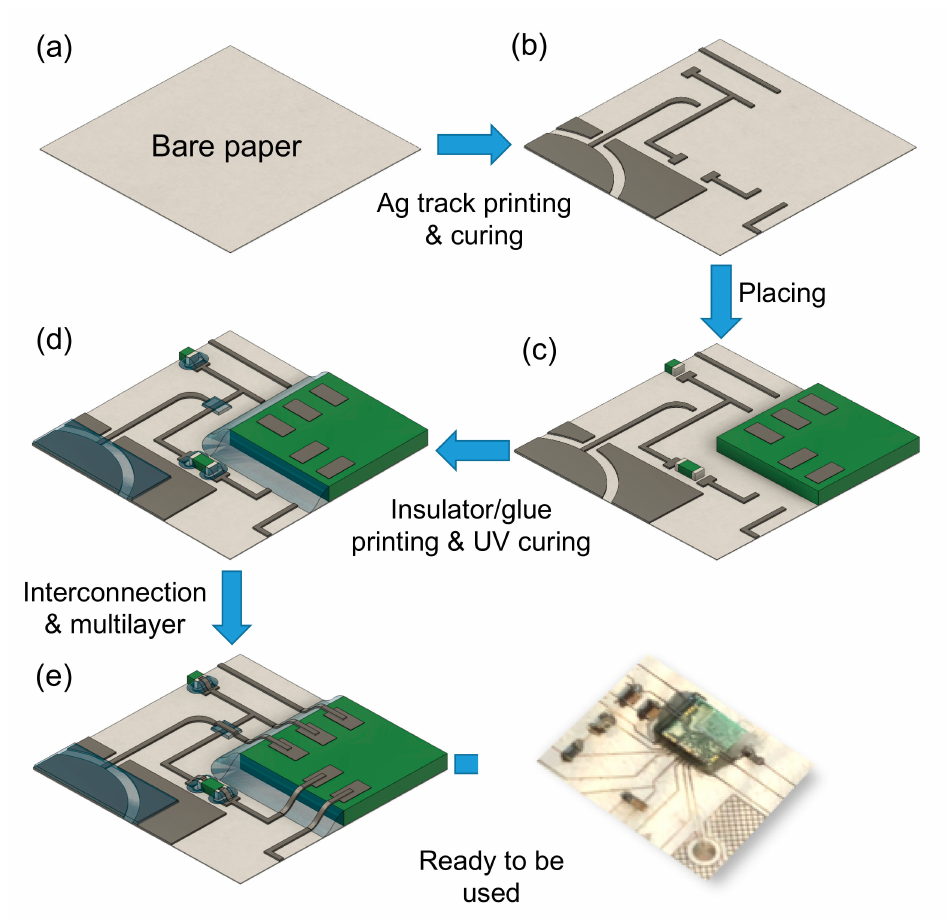
Figure 1. Block diagram of the circuit manufacturing steps: ( a ) bare paper; the first phase ( b ) regards Ag